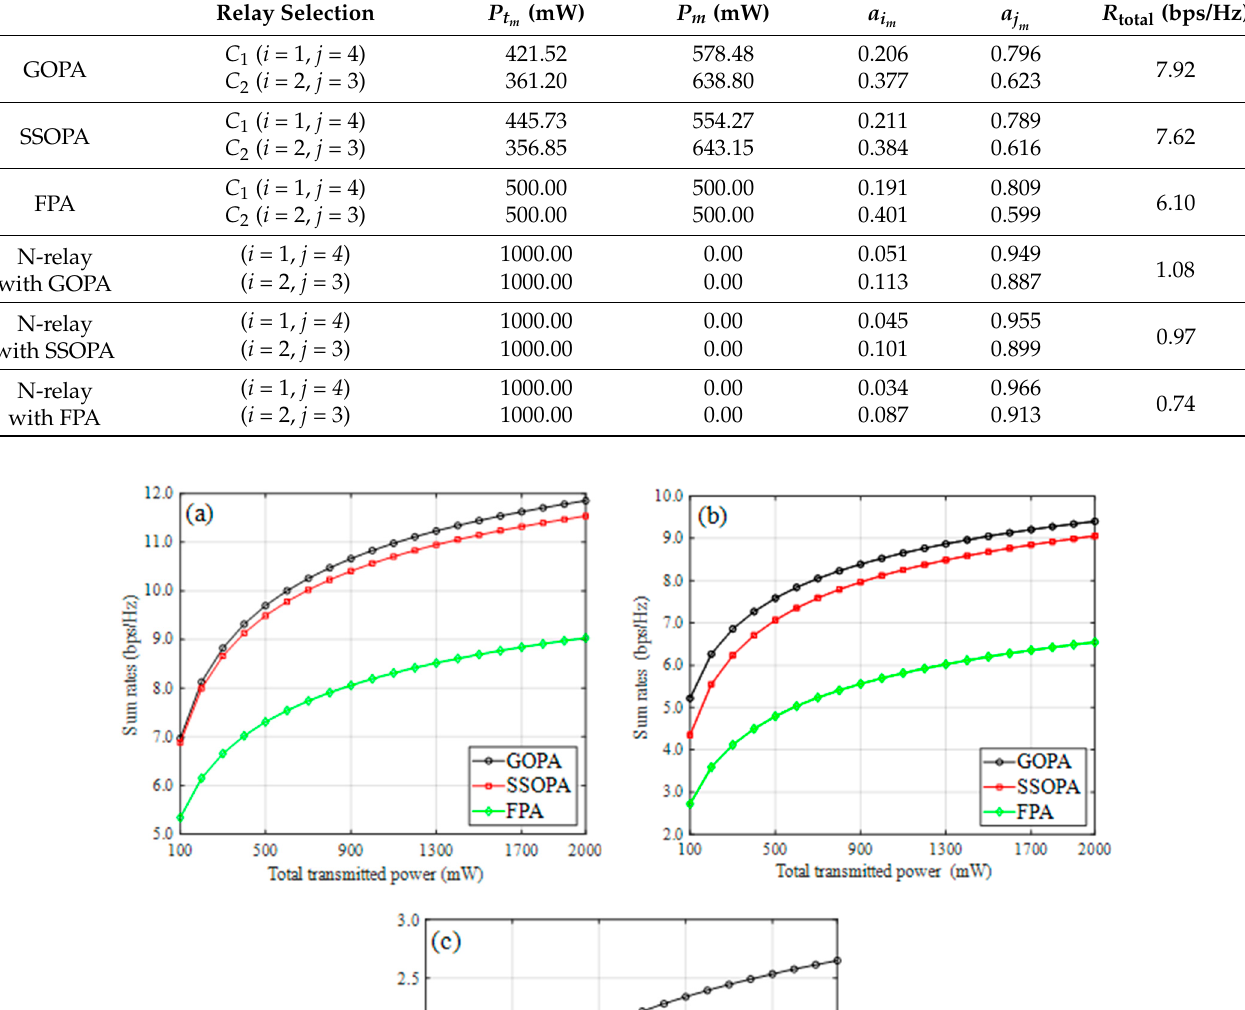
Table 6. Comparisons of three schemes for ICNOMA–UOWC.